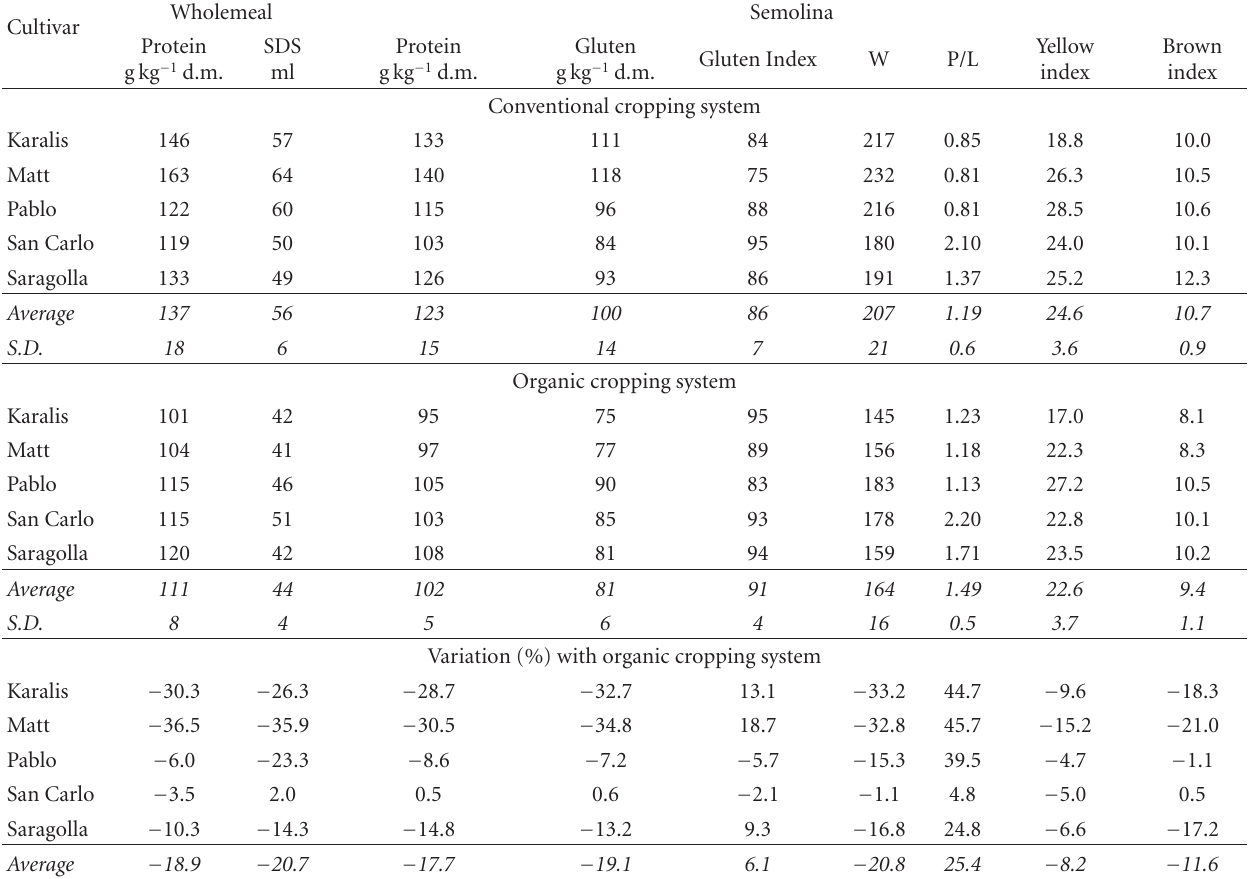
Table 4: Quality parameters of wholemeal and semolina of durum wheat varieties cultivated with conventional and organic cropping